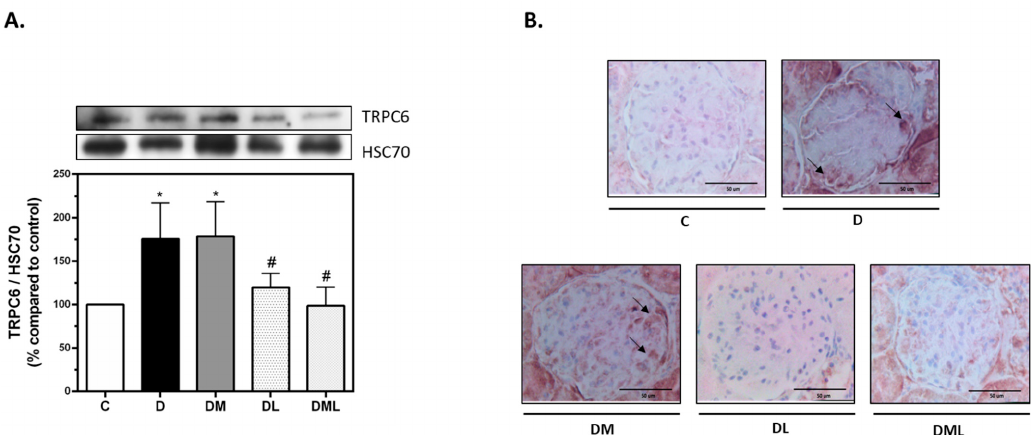
Figure 4. TRPC6 protein expression in the kidneys. ( A ) Representatives immunoblot of TRPC6 protein (up) and bar plot representing the quantification of TRPC6 expression against HSC70. ( B ) Representative microphotographies of the immunohistochemistry staining of TRPC6 as indicated by the black arrows (Magnification 40X, scale bar 50 μ m). HSC-70: Heat shock cognate. All data are expressed as mean ± SEM. * p ≤ 0.05 diabetic vs. control groups. # p ≤ 0.05 treated vs. diabetic groups.